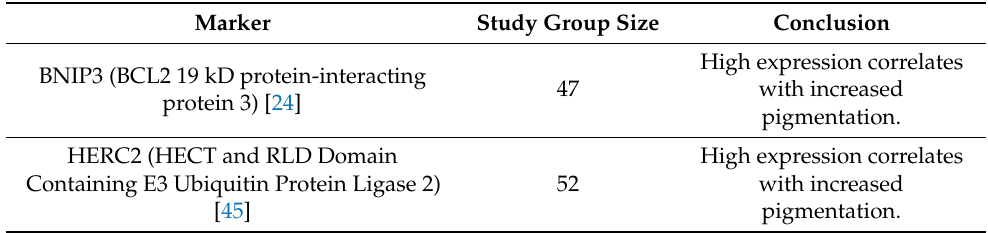
Table 10. Summary of markers whose expression is related to other prognostic factors.